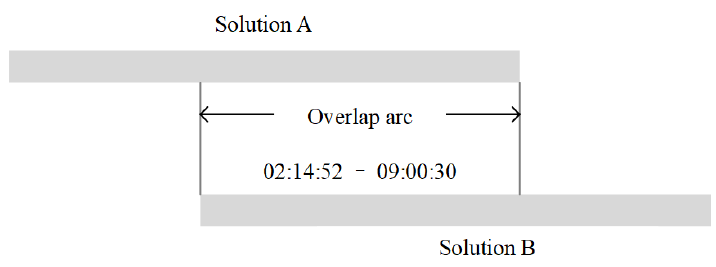
Figure 7. The concept of overlap comparison for the Luojia-1A precise orbit.